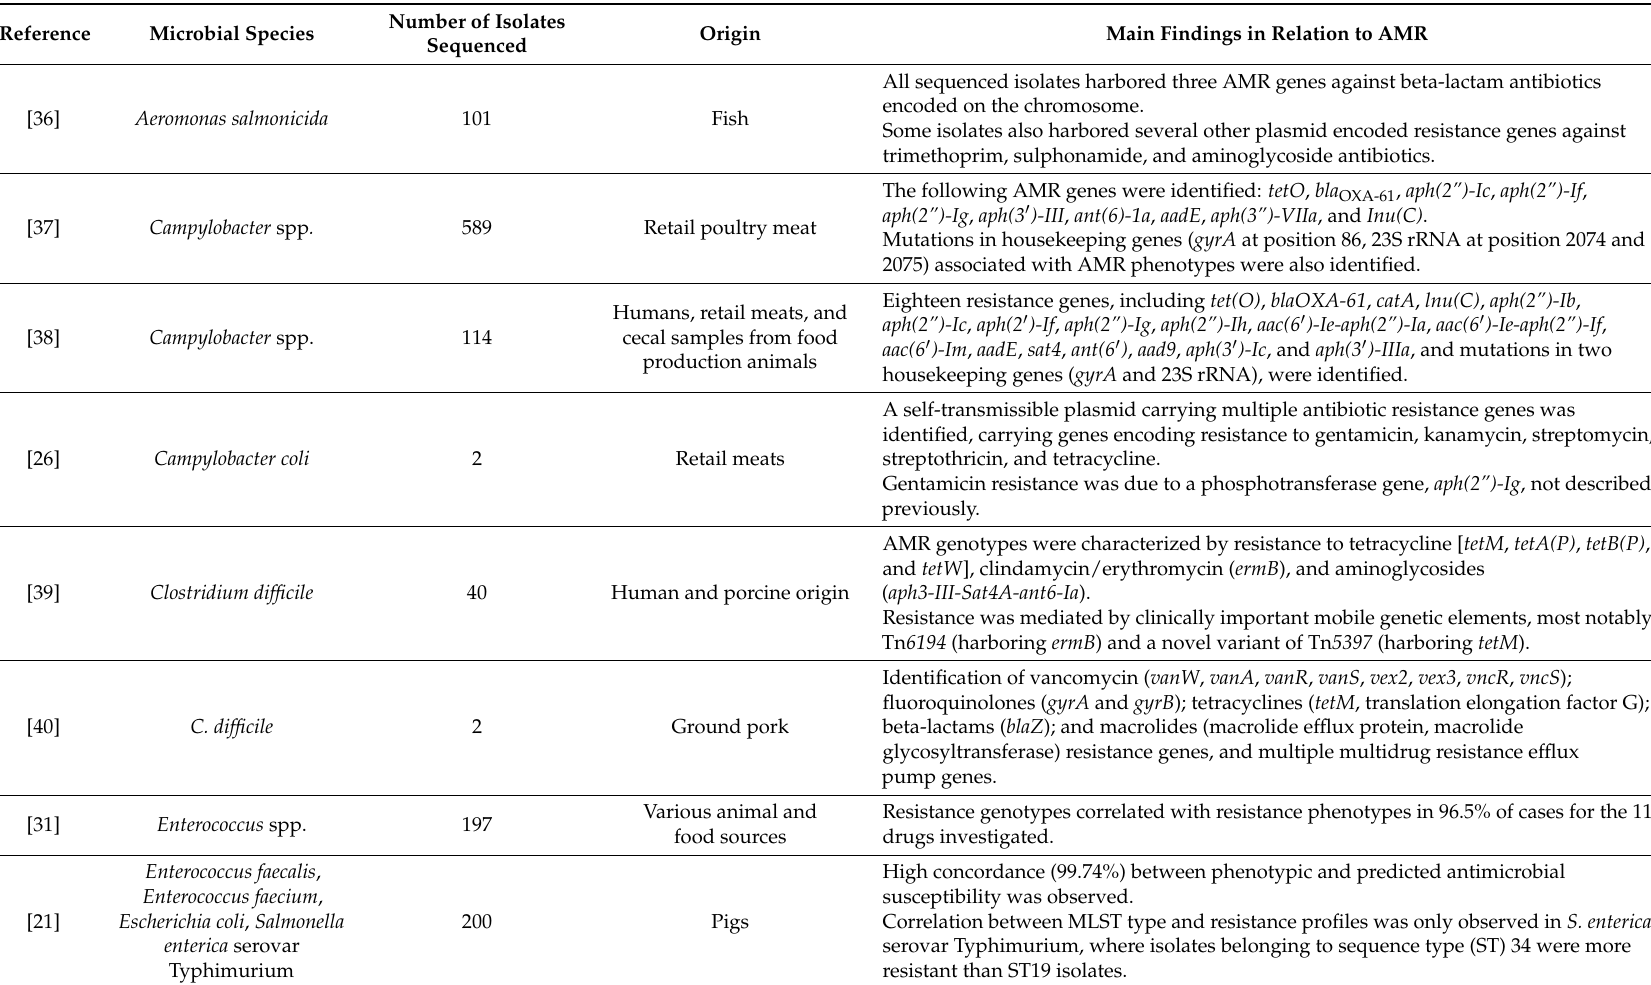
Table 1. Main research studies published in recent years applying whole genome sequencing (WGS) to characterize antimicrobial resistance (AMR) in foodborne